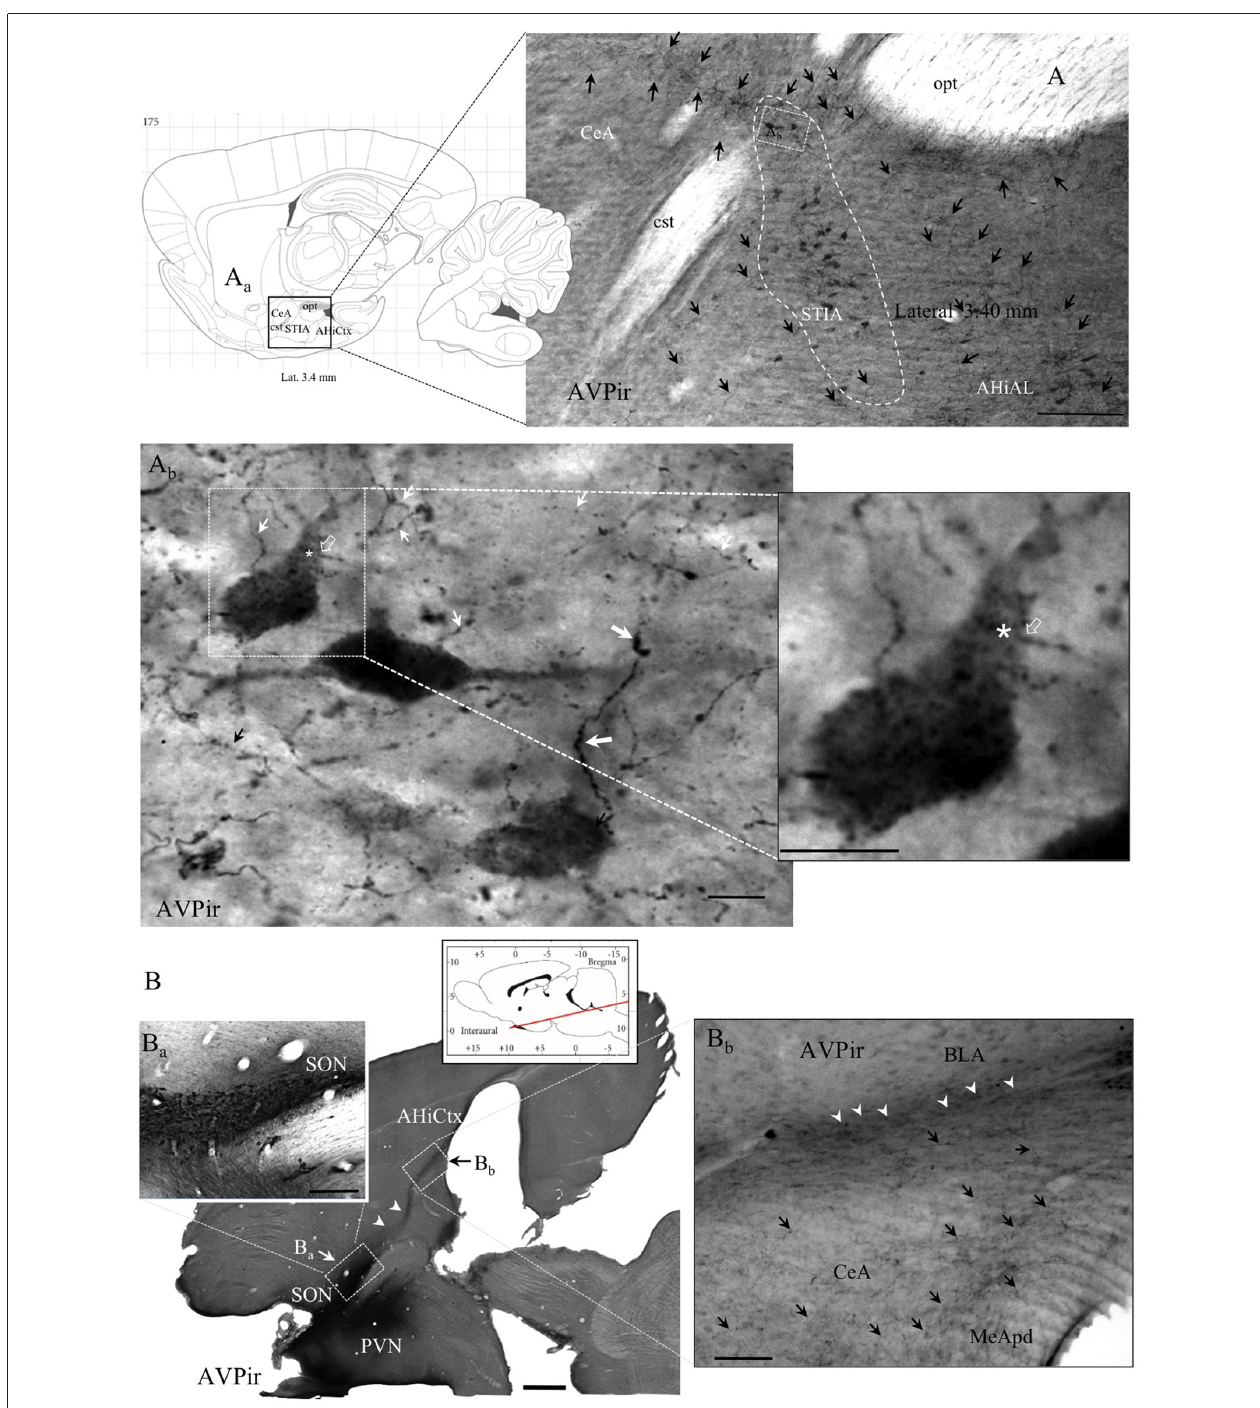
FIGURE 2 | Anatomo-immunohistochemical features of vasopressin immuno-reactive (AVPir) somata and fibers in the amygdaloidal complex suggest that AVP modulates distinct neuronal circuits. (A) Photomicrograph of AVPir in a sagittal section of rat amygdala at lateral 3.40 mm ( A a , inset: sagittal view of amygdaloid complex, squared region, from the Rat Brain Atlas). Note that the AVP immunopositive fibers (indicated by black arrows) are heterogeneously distributed in the whole amygdala complex and numerous AVP+ cells were inside the bed nucleus of stria terminalis , intra-amygdaloid division (STIA; circumscribed with white dashed line). (A b ) Amplification of a region inside the STIA. Note that there are two types of AVPir+ fibers, regarding their thickness and spatial frequency of varicosities: the type I fibers have thick diameter and frequent varicosities (thick white arrows); the type II fibers are thin and had less frequent varicosities (thin white arrows). Both types are intermingled in the same region. The asterisk indicates the site where one thin-type axon (the axon initial segment was indicated with